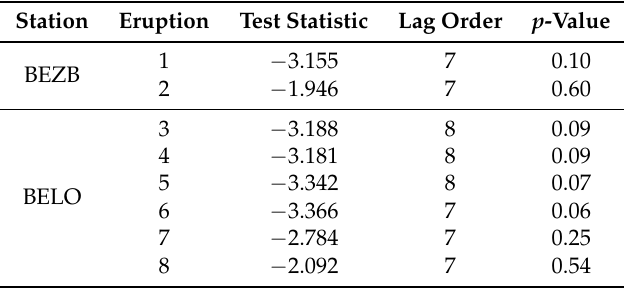
Table 2. ADF test results for different eruption times of Volcano at the two seismic